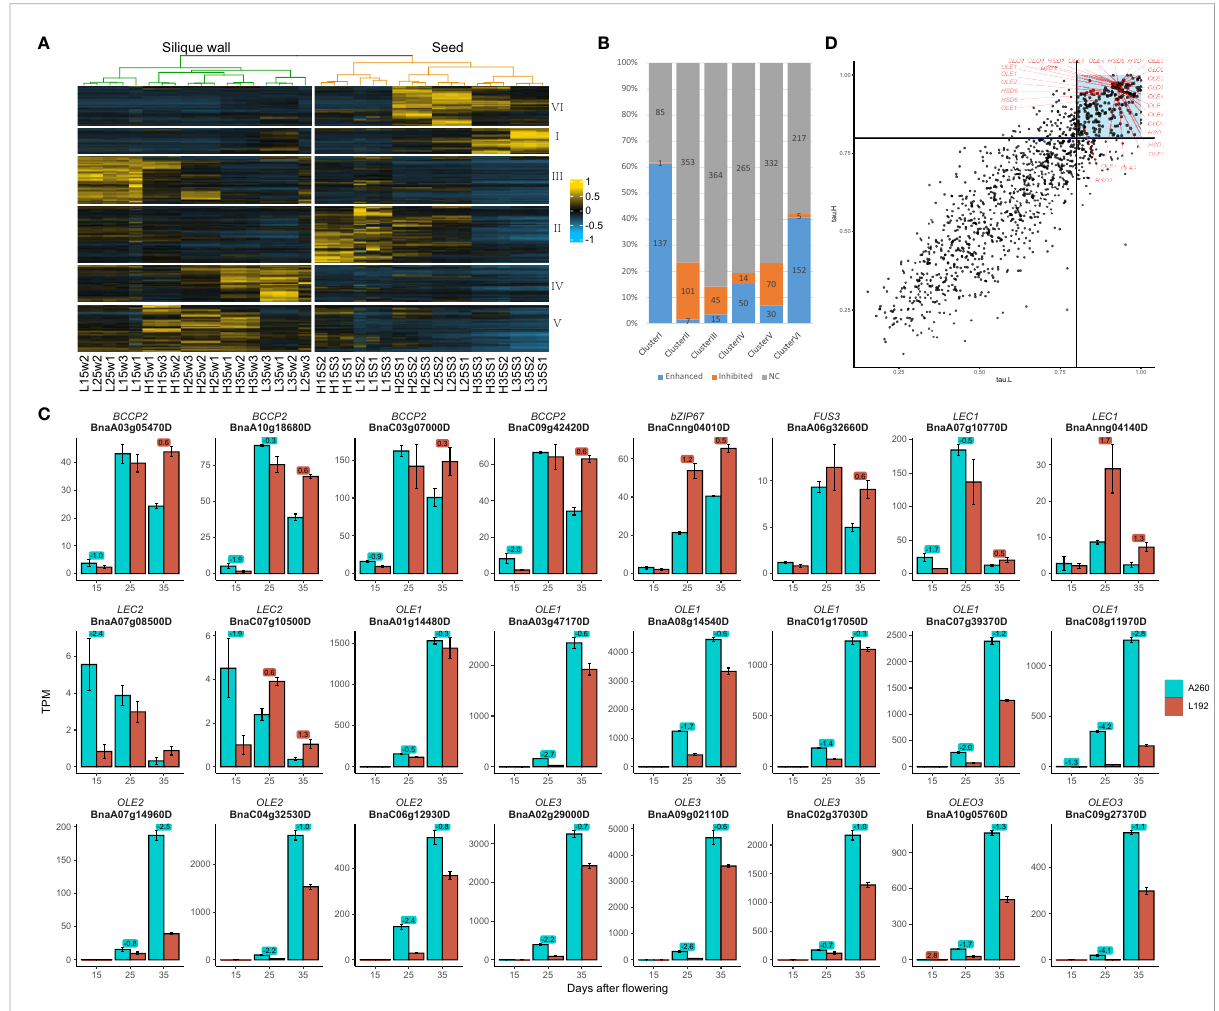
FIGURE 3 Expression of genes related to the lipid pathway in the two genotypes. (A) cluster analysis of genes relative to the lipid pathway (Supplementary Table 6). H, samples of L192 (high oil content). L, samples of A260 (low oil content). S, seed. W, silique wall. 15, 25 and 35, 15, 25 and 35 days after fl owering, respectively. The number at the end of the sample name was the code number of three biological replicates. (B) the ratios of the enhanced or inhibited genes over the period investigated in each cluster. The numbers were counts of genes enhanced, inhibited or no change (NC) by time-course in each cluster (Supplementary Table 6). (C) Expression pro fi les of some important genes related to lipid biosynthesis in the seed. The bars represent means of three biological replicates (TPM value), error bars are the standard deviation, and the numbers on the bars are the logFC (FC, fold change, comparison of L192 versus A260 at 15, 25 or 35 DAF). (D) The tau indices of genes relative to the lipid pathway in L192 (tau.H) or A260 (tau.L). The blue lines were where the tau index was equal to 0.8. Genes with the tau index greater and equal to 0.8 are more speci fi cally expressed in one sample (Kryuchkova-Mostacci and Robinson-Rechavi, 2017). The tau indices of the oil body proteins (Supplementary Table 3) were greater than 0.8 and marked with red lines. OLE Oleosin , CLO Caleosin , HSD Hydroxysteroid dehydrogenase . The points in the blue block represented tau indices of genes both in L192 and A260 were greater than